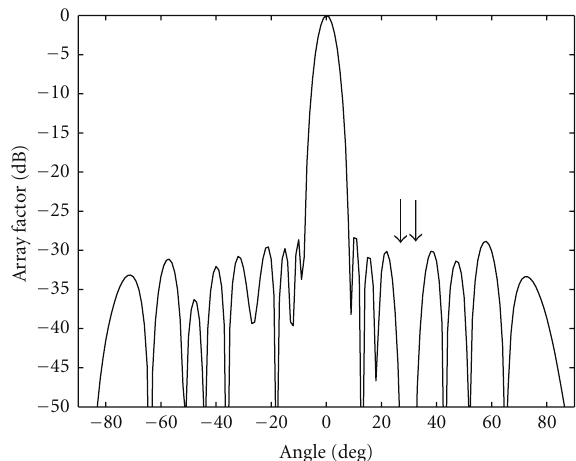
Figure 11: Radiation pattern of the same linear array with imposed nulls at − 20 ◦ , 33 ◦ , and 50 ◦ .